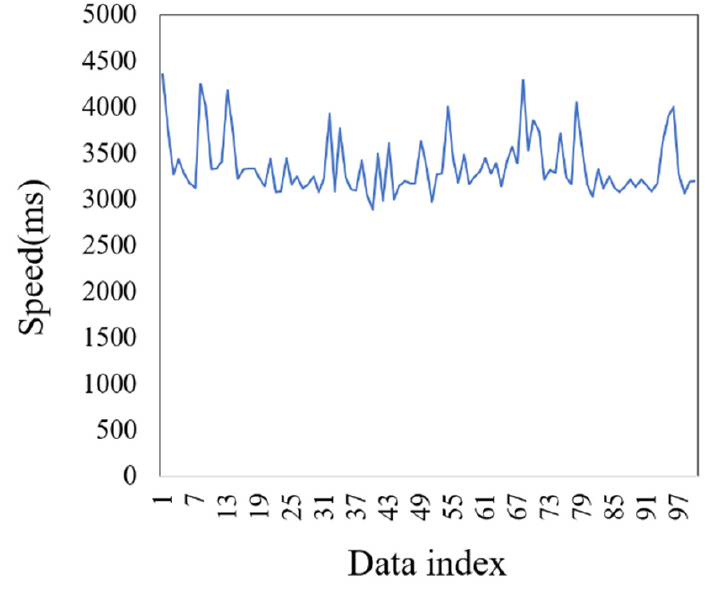
Figure 12. Data sharing speed.